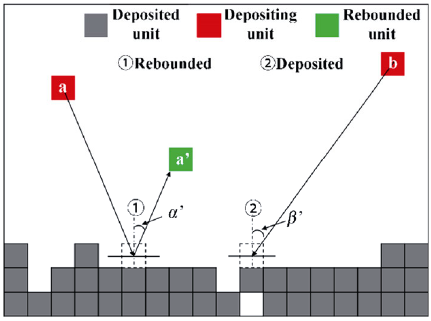
Fig. 76 Vapor ballistic deposition (VBD) model. Reproduced with permission from Ref. [414], © Published by Elsevier B.V. 2019.